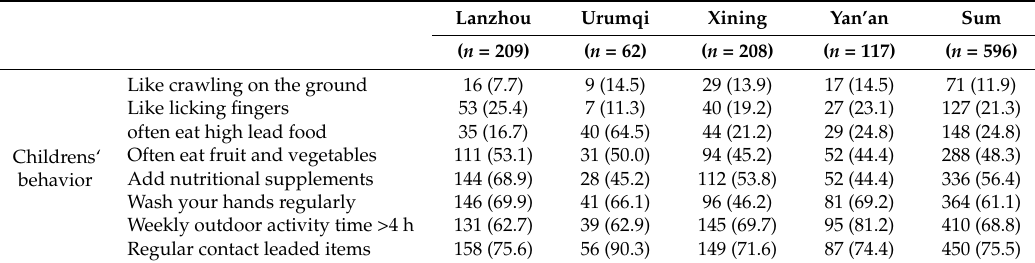
Table 5. Children’s behavior in different